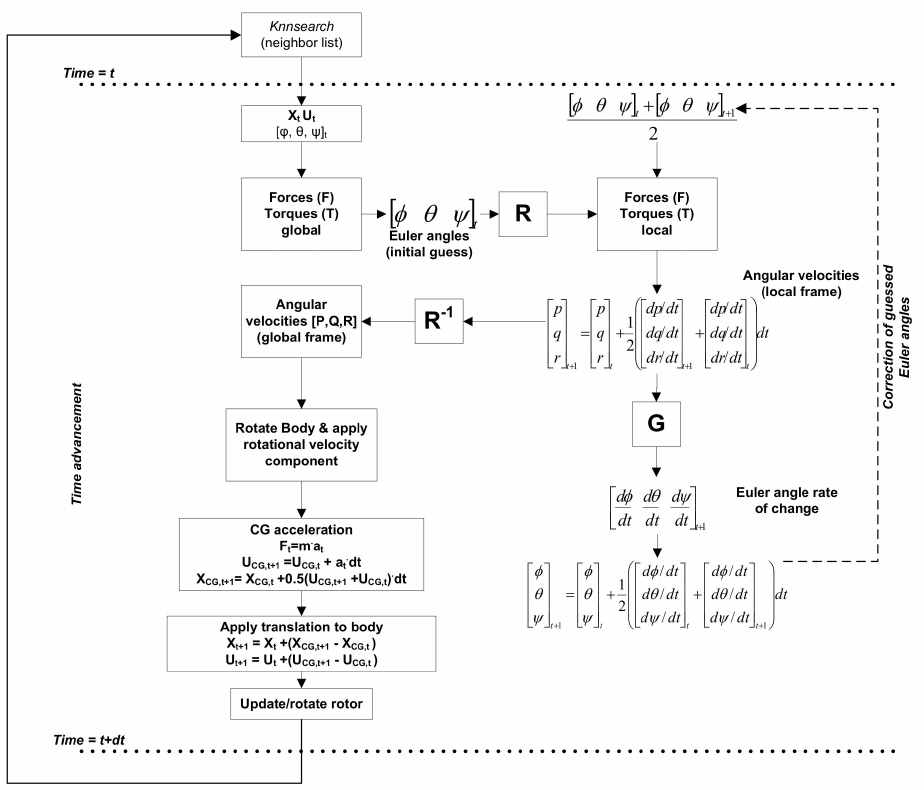
Figure 2. The algorithm used for 6-DoF body